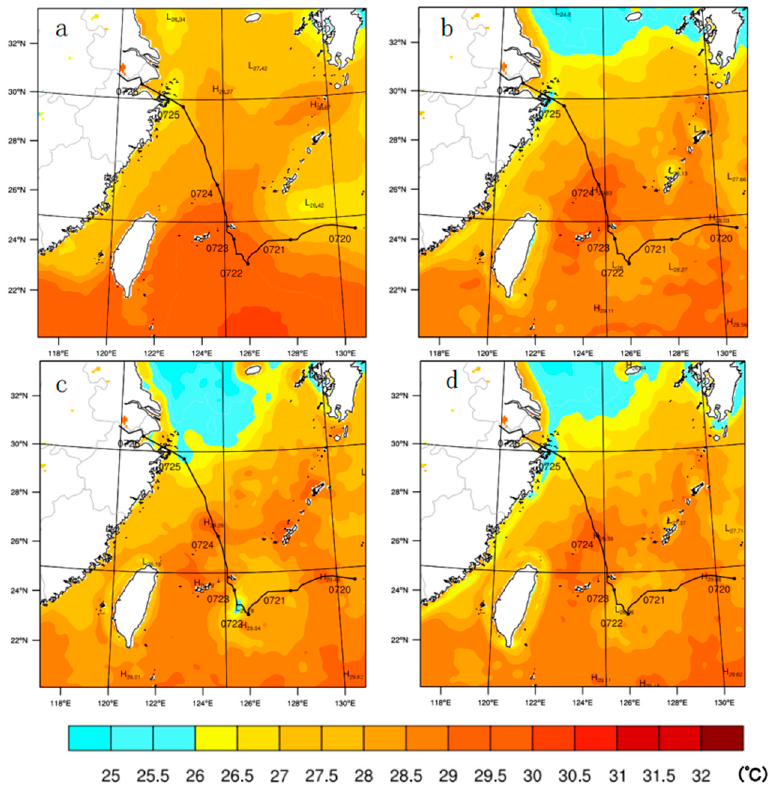
Figure 3. Initial sea surface temperature (unit: °C) from CTRL ( a ), fy3_a ( b ), fy3_d ( c ), fy3_m ( d ).